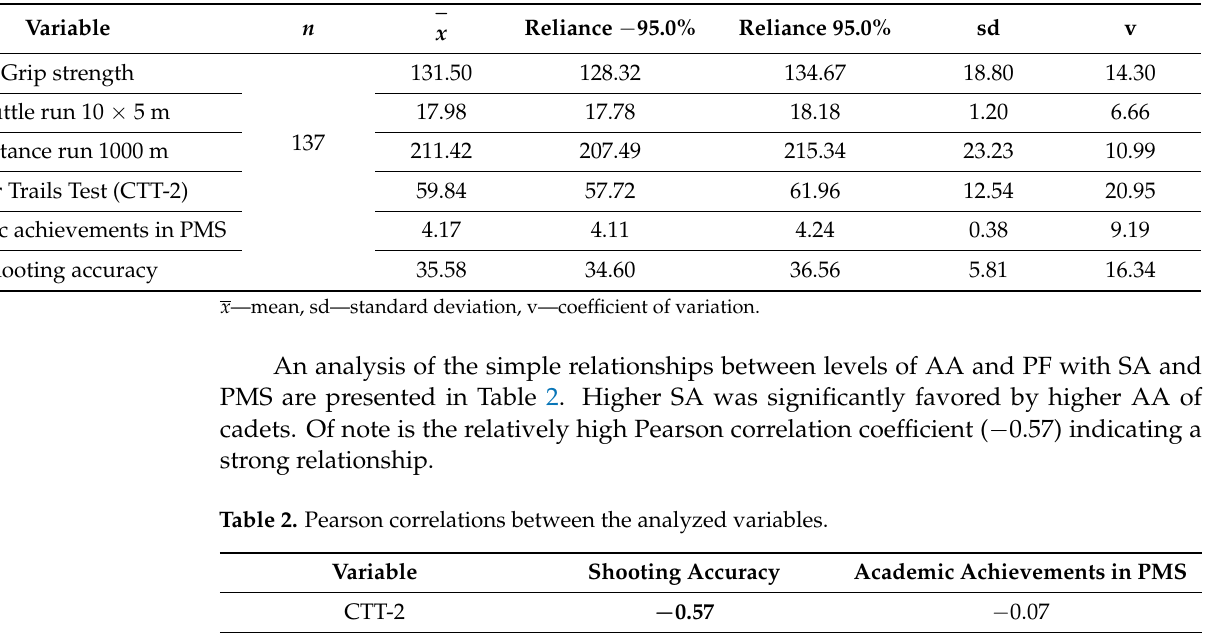
Table 2. Pearson correlations between the analyzed variables.